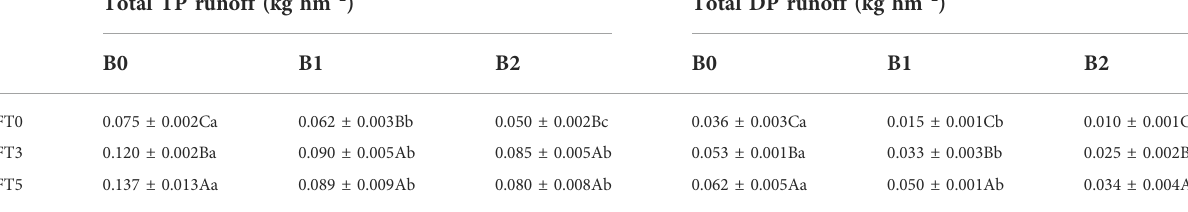
TABLE 4 Total phosphorus (TP) and dissolved phosphorus (DP) loss in slope with different biochar application